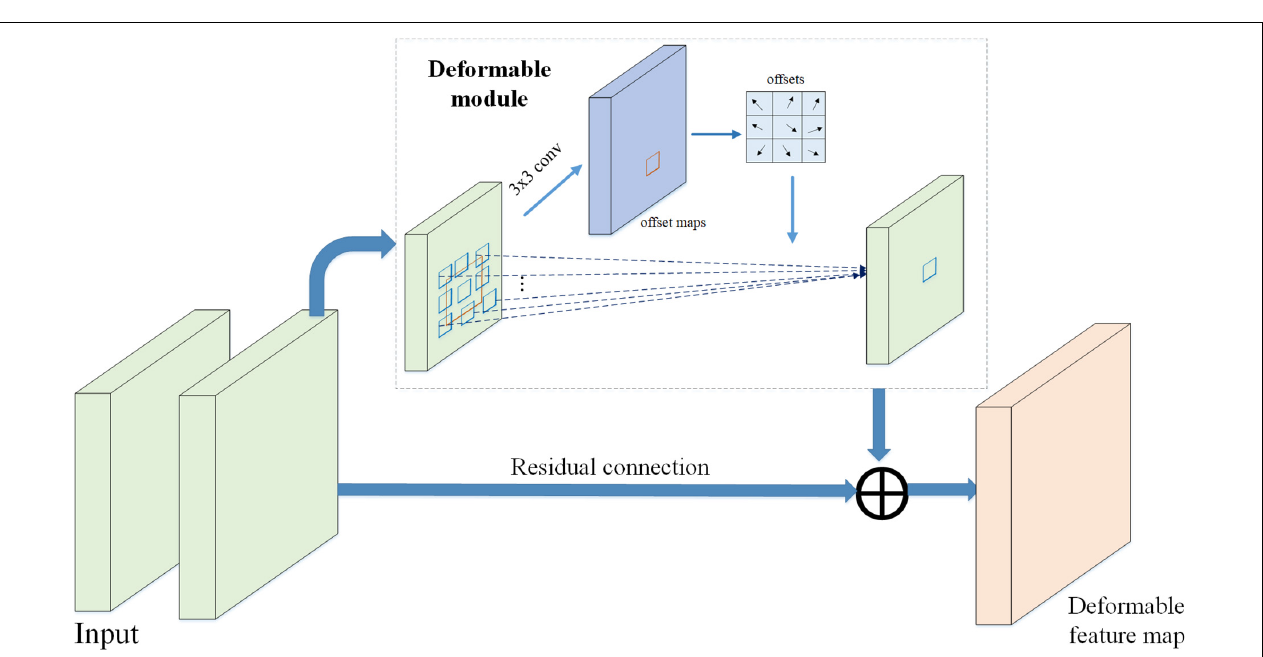
FIGURE 4 | Architecture of the deformable residual